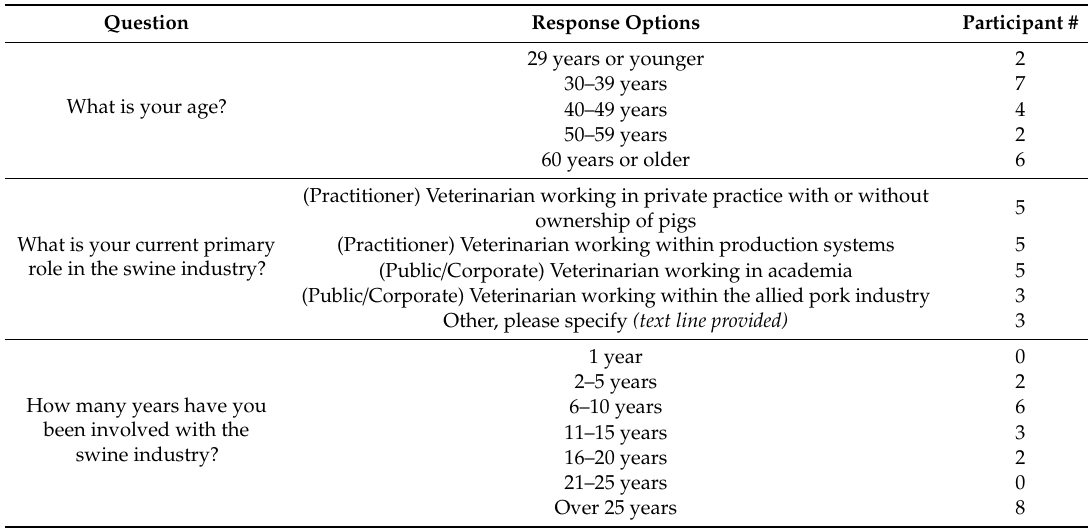
Table 2. Focus group participant demographic